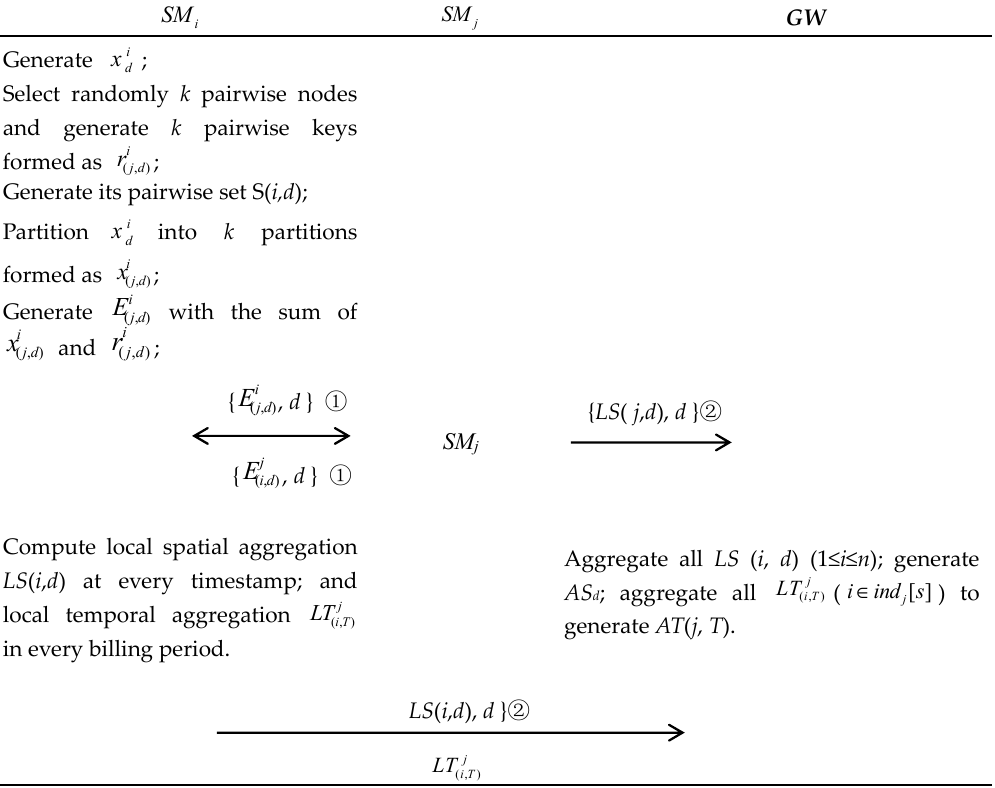
Figure 3. Communication process data between the pairwise nodes and GW.